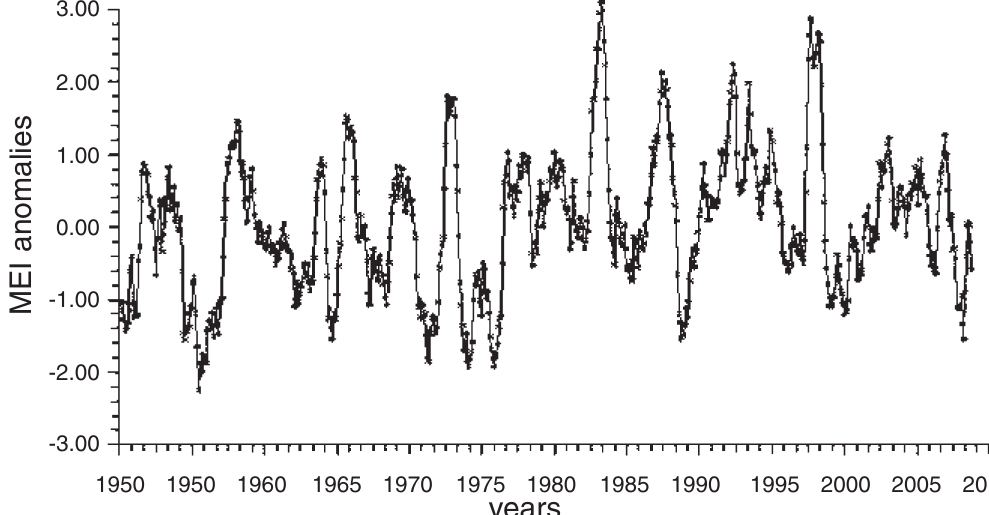
Fig. 1. Time series plot of MEI monthly values from January 1950 to December